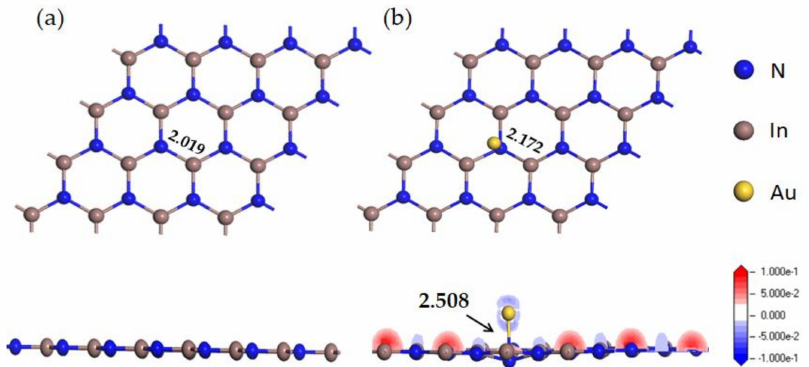
Figure 2. ( a ) The top and side view of InN monolayer; ( b ) The top view of Au-InN monolayer and DCD in side view. Bond length is shown in